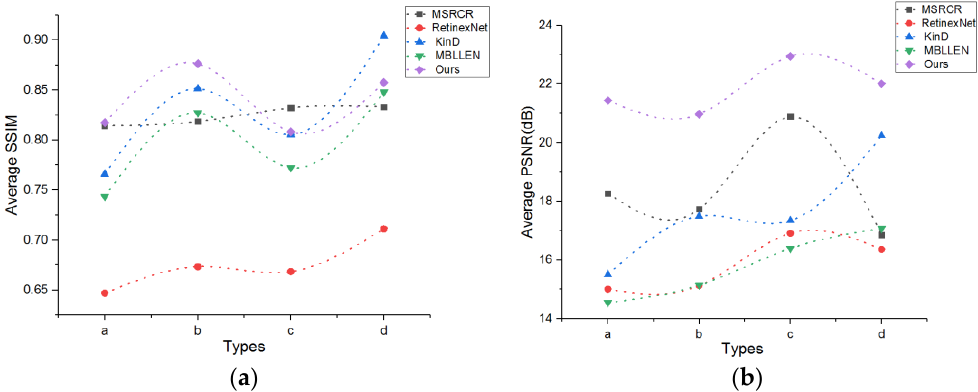
Figure 8. Objective performance evaluation of the different algorithms in special images considering; ( a , b ) are the average SSIM, and average PSNR for the four types of scenes. The original discrete points are fitted into a curve to provide an enhanced viewing effect.